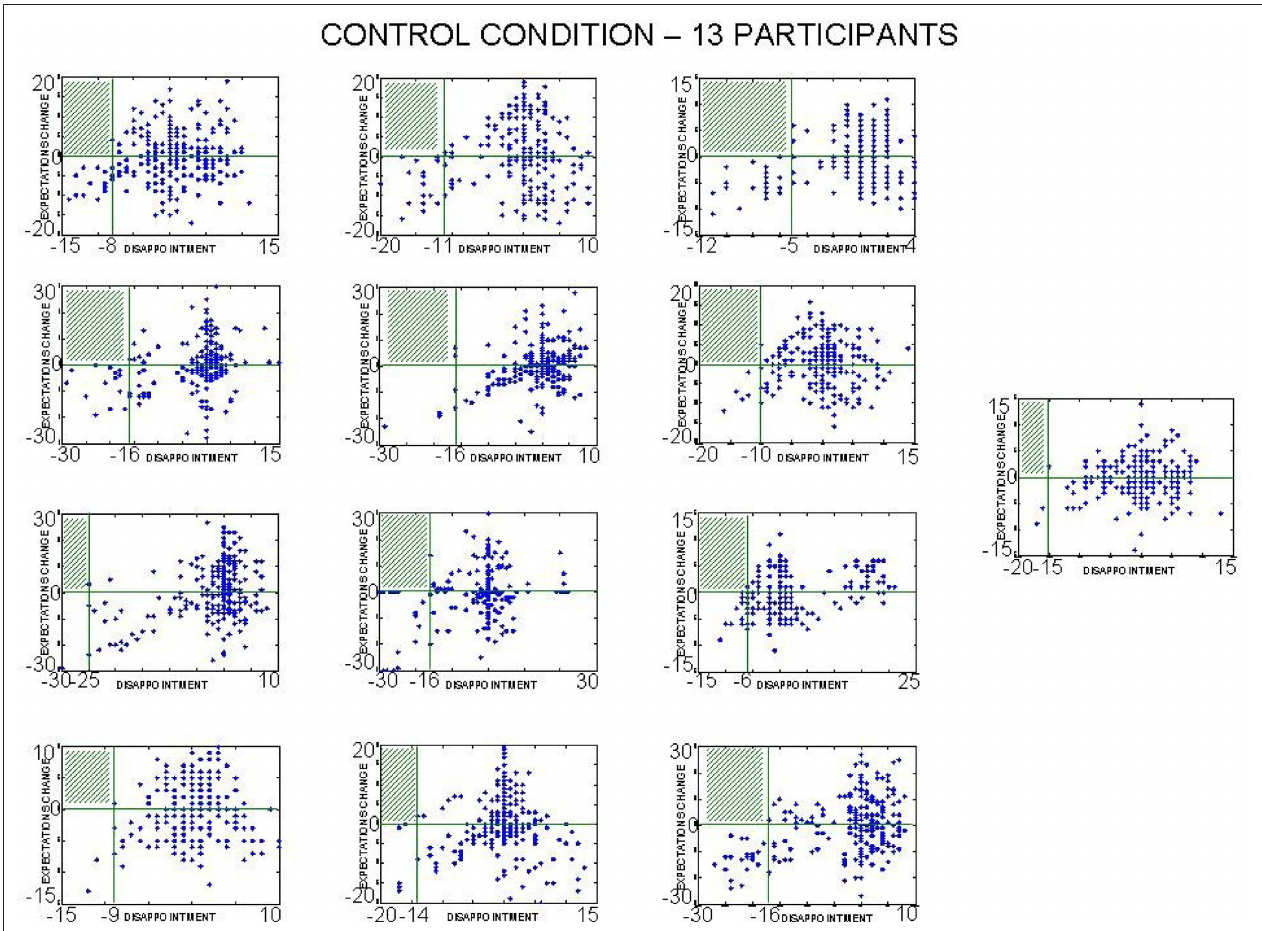
Figure A2 | DTT for single subjects in the Control Condition. The dashed green zone represents the absence of positive change in expectations in actual trial compared to previous trial, and is present for all 11 subjects of the control condition